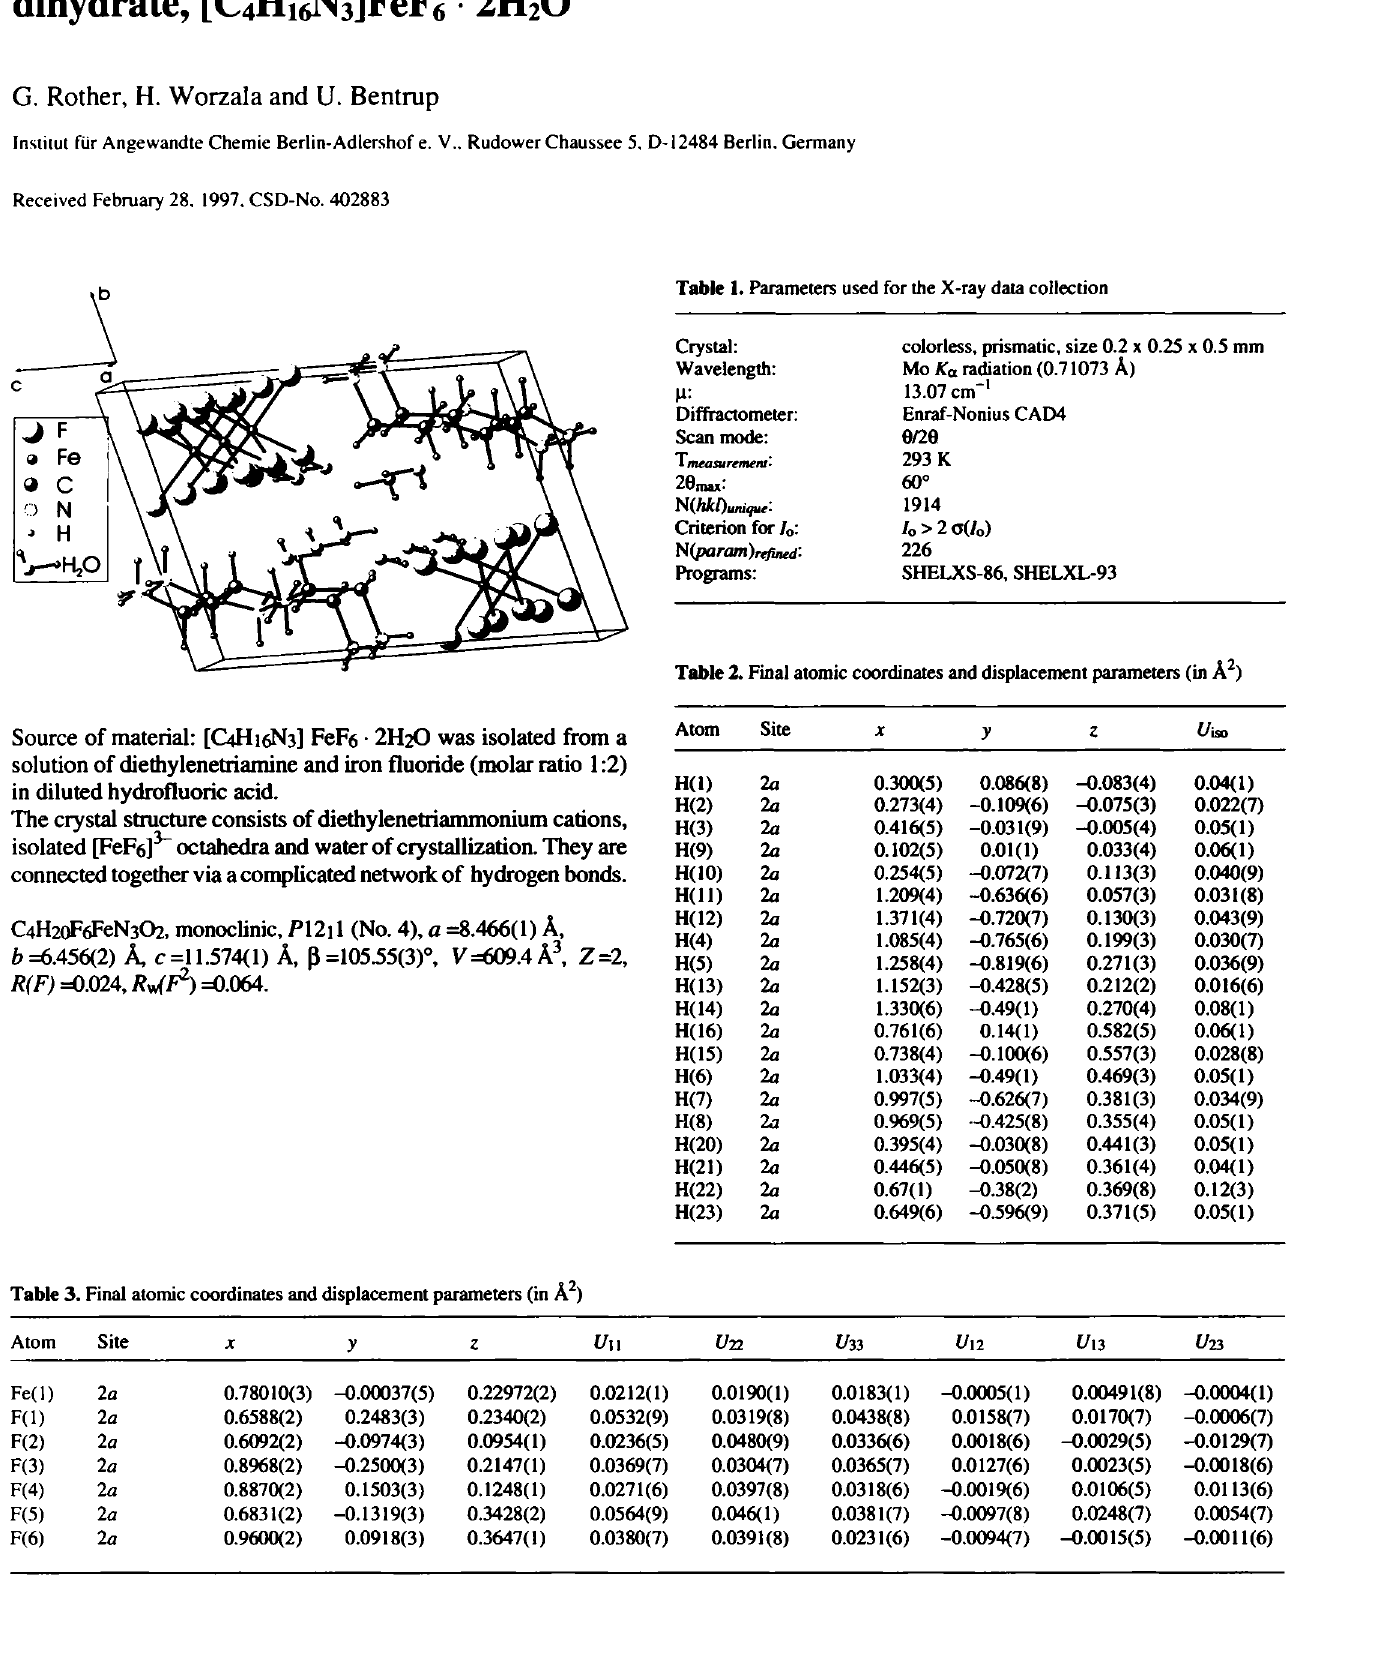
Table 1. Parameters used for the X-ray dala collection